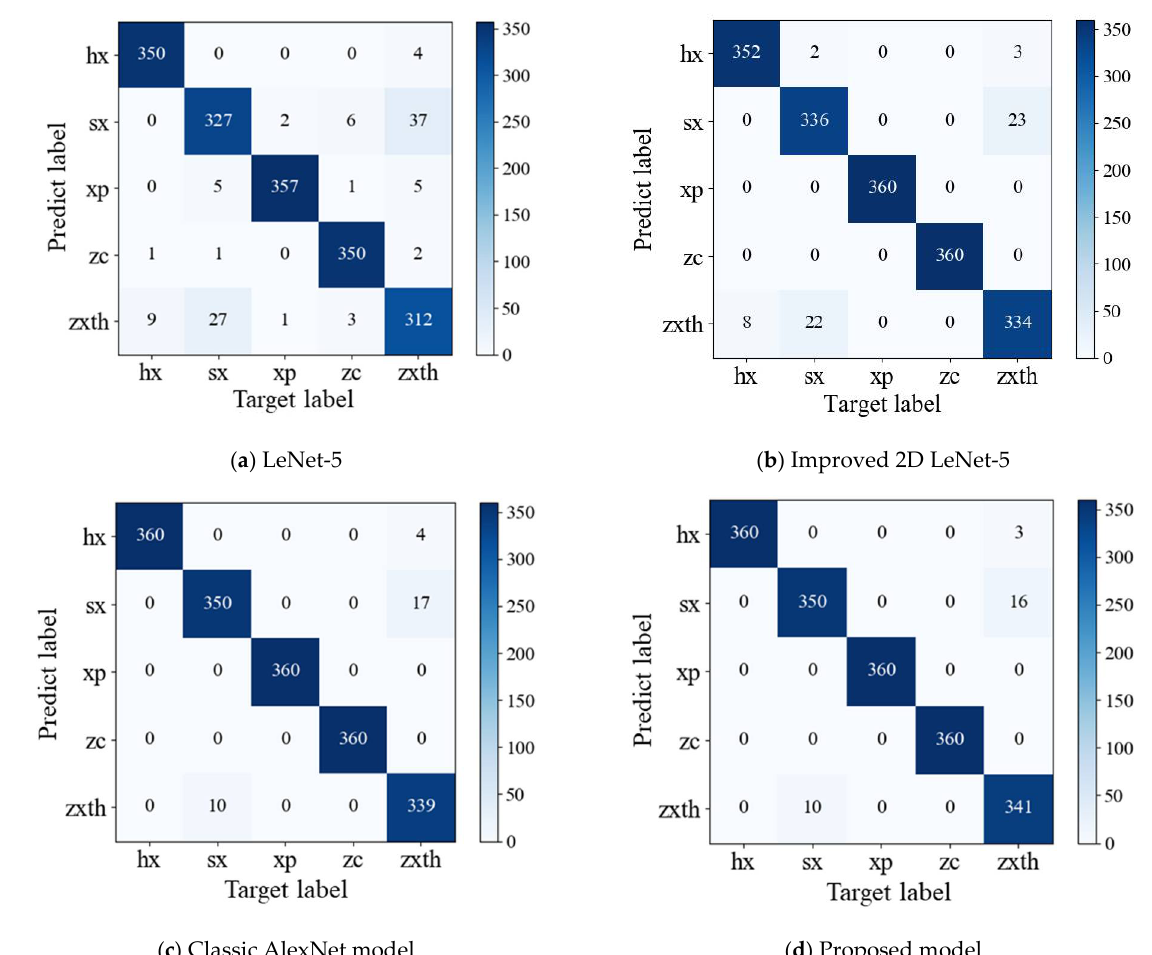
Figure 10. Comparison of model classification effect.